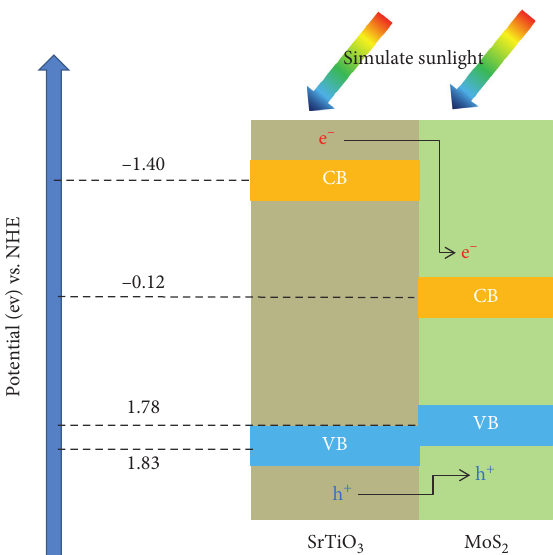
Figure 4: Schematic diagram of the photoelectric conversion mechanism of SrTiO